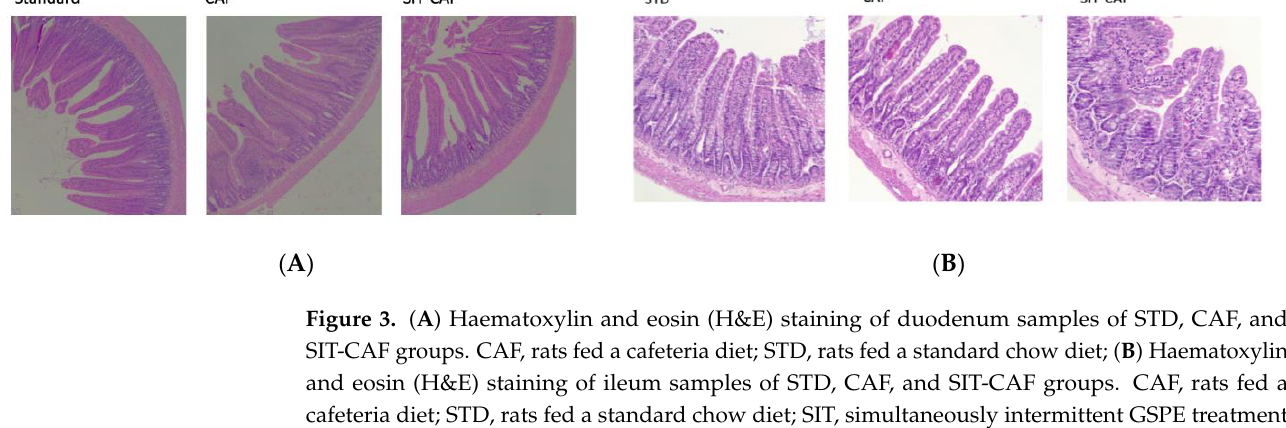
(500 mg/kg body weight).